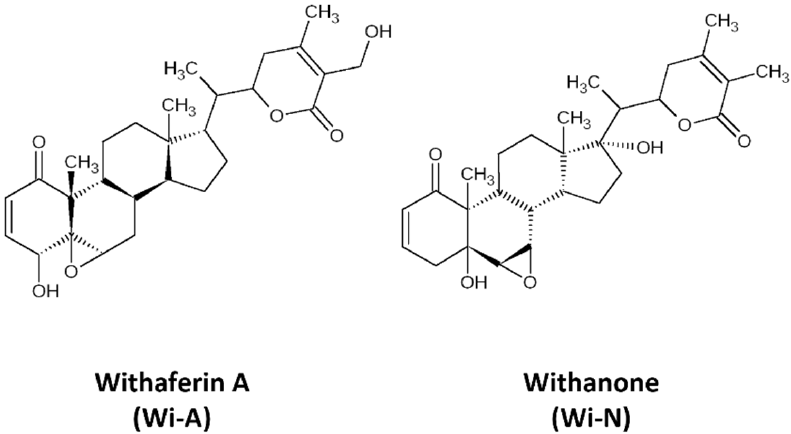
Figure 1. The 2D representations of structures of Withaferin A (Wi-A) and Withanone (Wi-N).